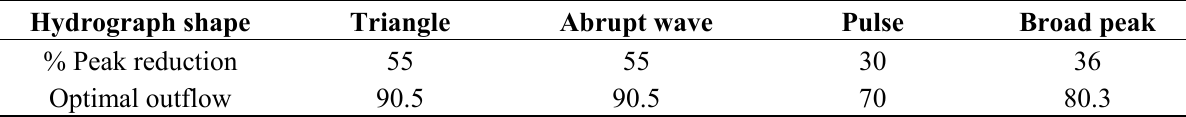
Table 2. Modeled results of the minimize flood peak with a perfect forecast operating rule. Storage = 3000 units, Percent of the hydrograph contained = 30%. Hydrograph